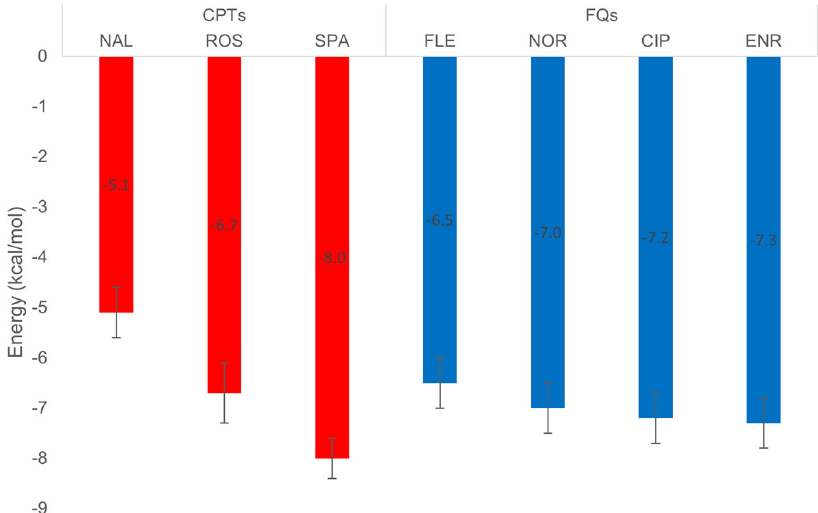
Fig. 6 Average binding af fi nities from ensemble docking calculations. Average binding af fi nities (±SD, n = 180) for each ligand as obtained through molecular docking performed using an ensemble of 18 X-ray conformations of